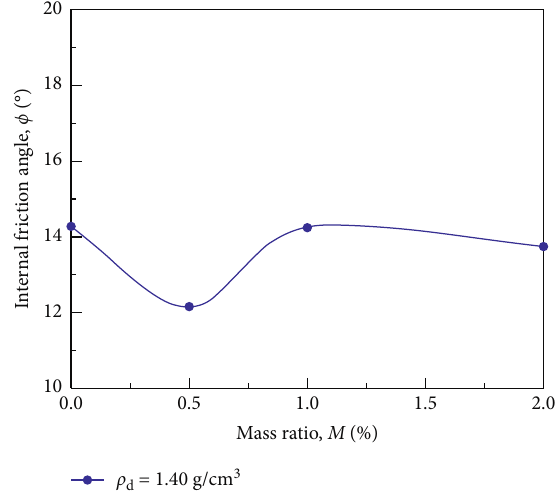
Figure 9: Effect of mass ratio on cohesion.